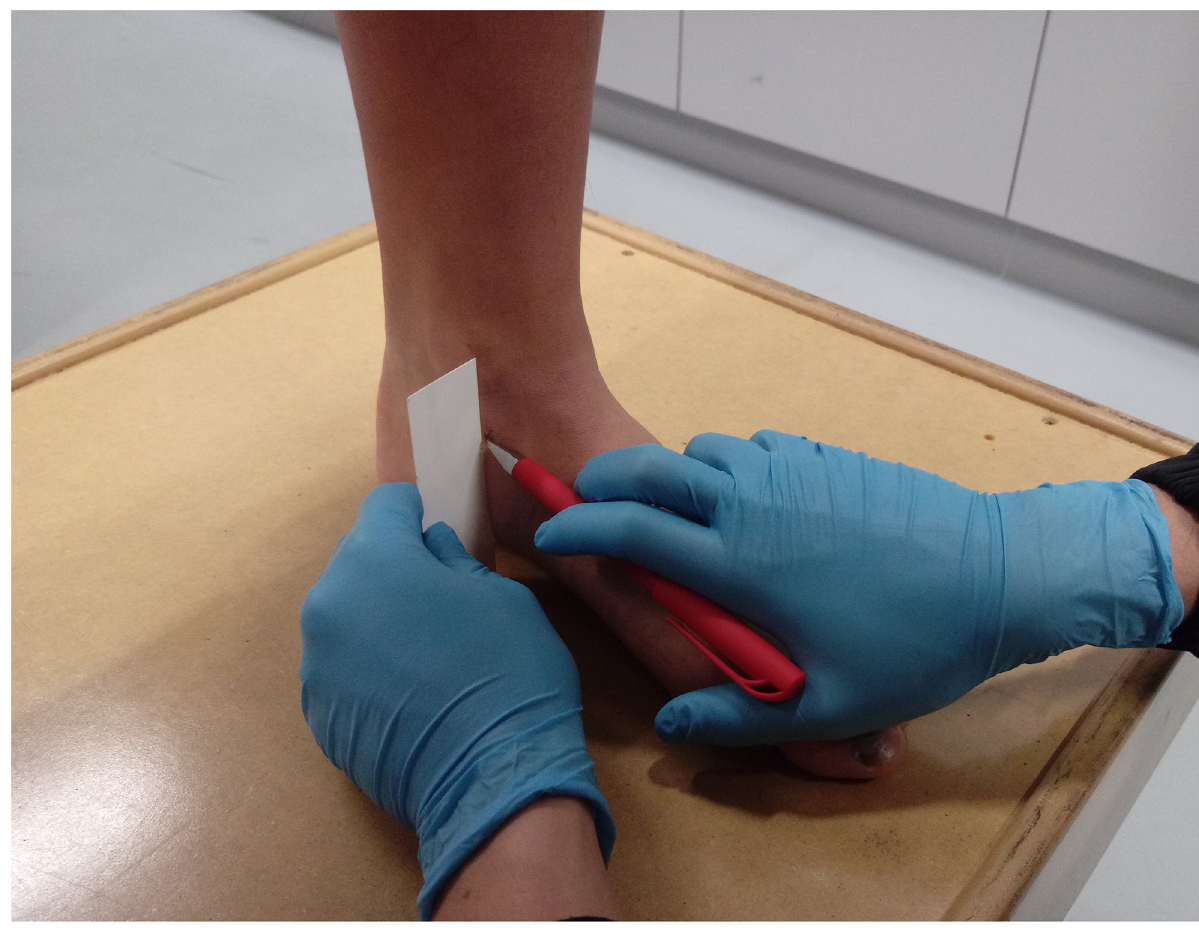
Fig 1. Navicular drop